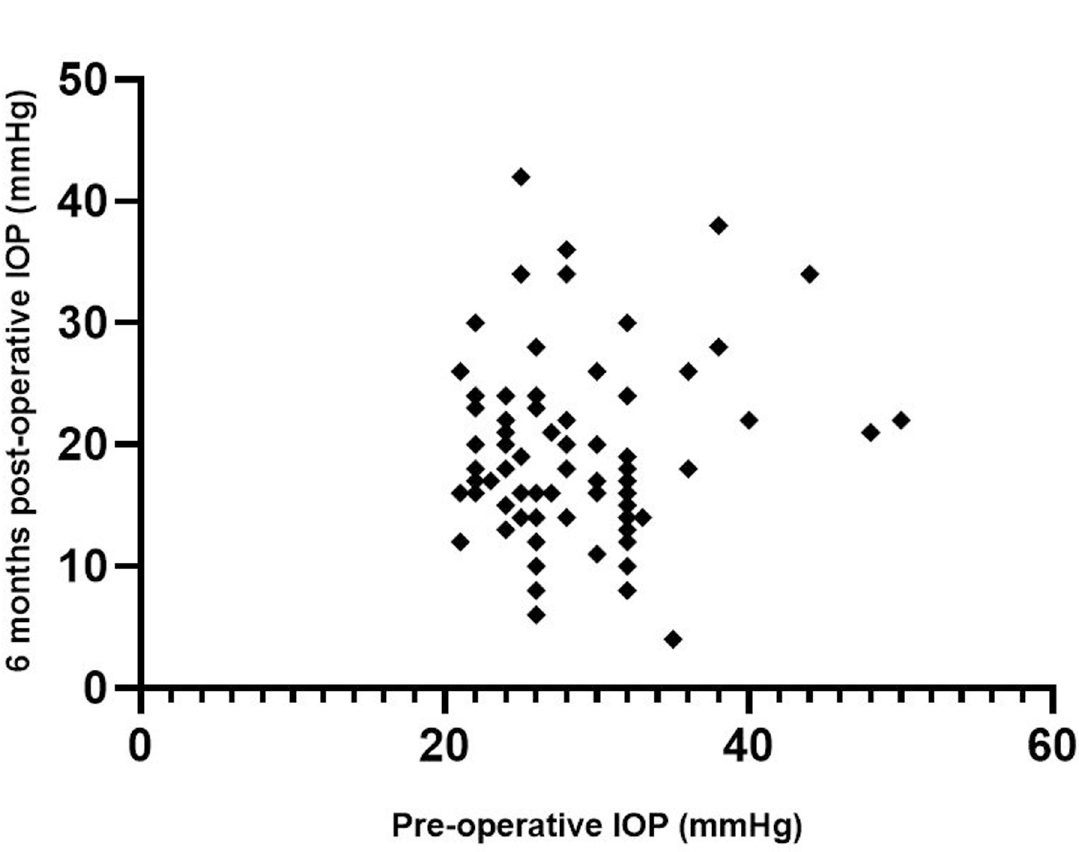
Fig 3. Scatter plot showing 6-month post-operative IOP according to pre-operative IOP. IOP, intraocular pressure.